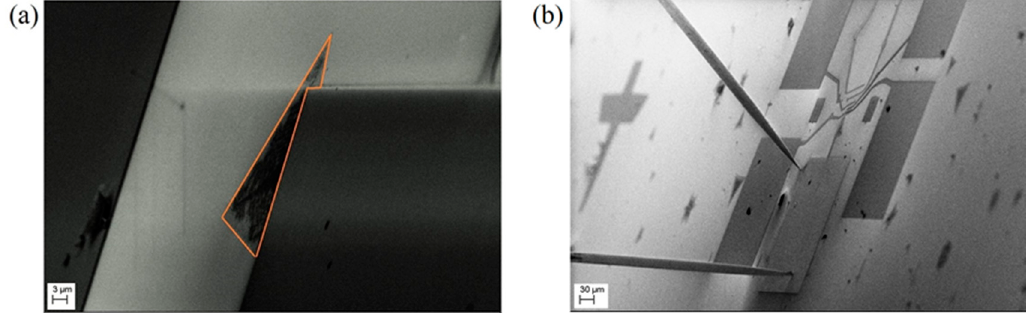
Figure 3. ( a ) SEM image of a MoS 2 flake used for field emission measurements; ( b ) SEM image showing the positioning of the tungsten tips: the lower W -tip is on the metal pad contacting the flake, the other one is placed in front of the flake at a close distance d.